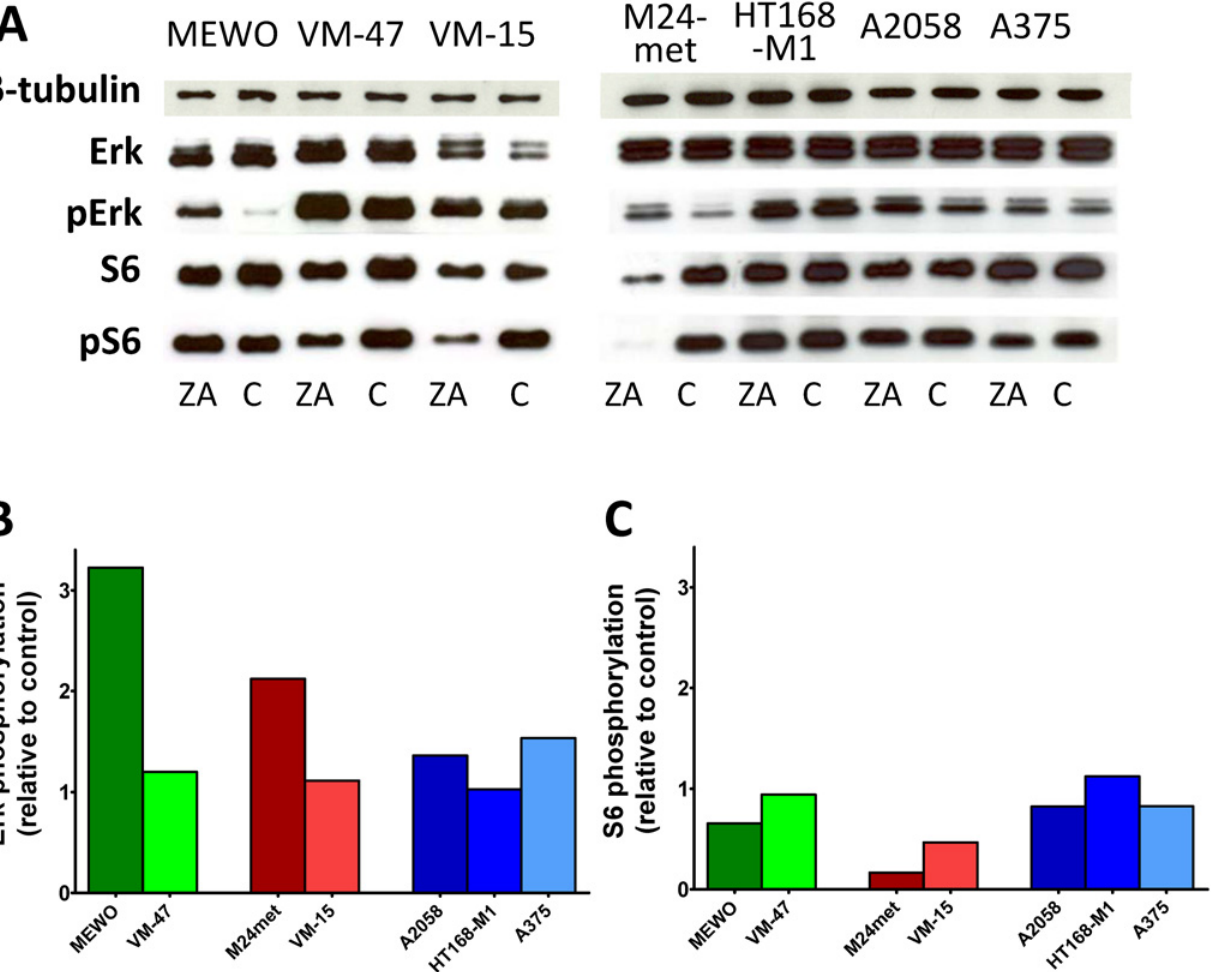
Fig 3. Activation of downstream elements of the RAS/RAF pathway in melanoma cells after zoledronic acid treatment. ( A ) Representative blots of the effect of 48hs zoledronic acid (ZA) treatment on the activation of Erk1/2 and S6. ( B ) Quantification of the effect of ZA treatment on the activation of Erk1/2. Treatment with ZA resulted in robust increase in the phosphorylation of Erk1/2 in MEWO and M24met cells. ( C ) Quantification of the effect of ZA treatment on the activation of S6. After the treatment with ZA, decreased activation of S6 proteins was found only in NRAS mutant M24met and VM-15 cells. Colors blue, red and green indicate BRAF, NRAS mutation and wild-type for these genes, respectively. (C = control; ZA = zoledronic acid).